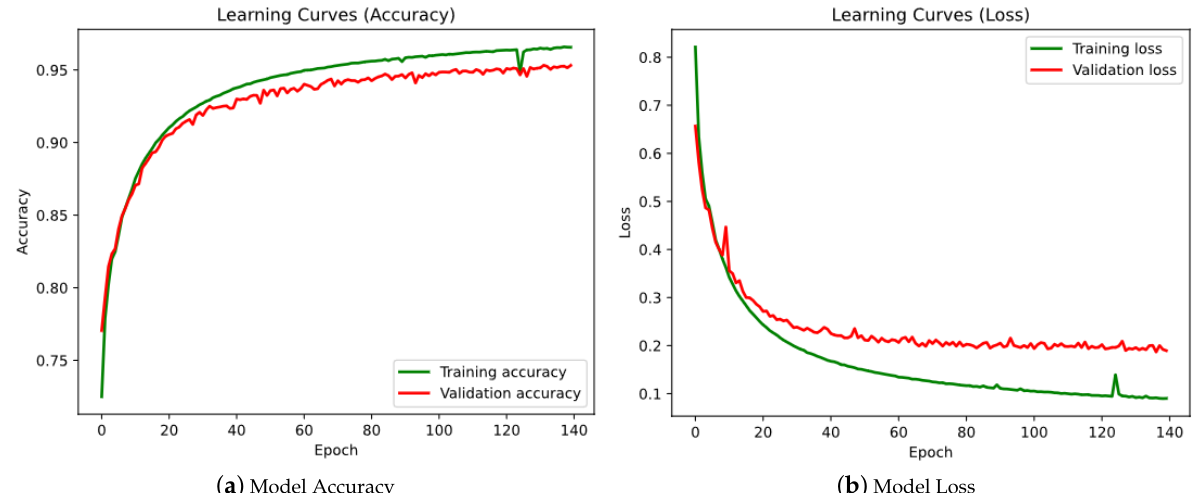
Figure 6. Bi-directional LSTM-based neural network learning